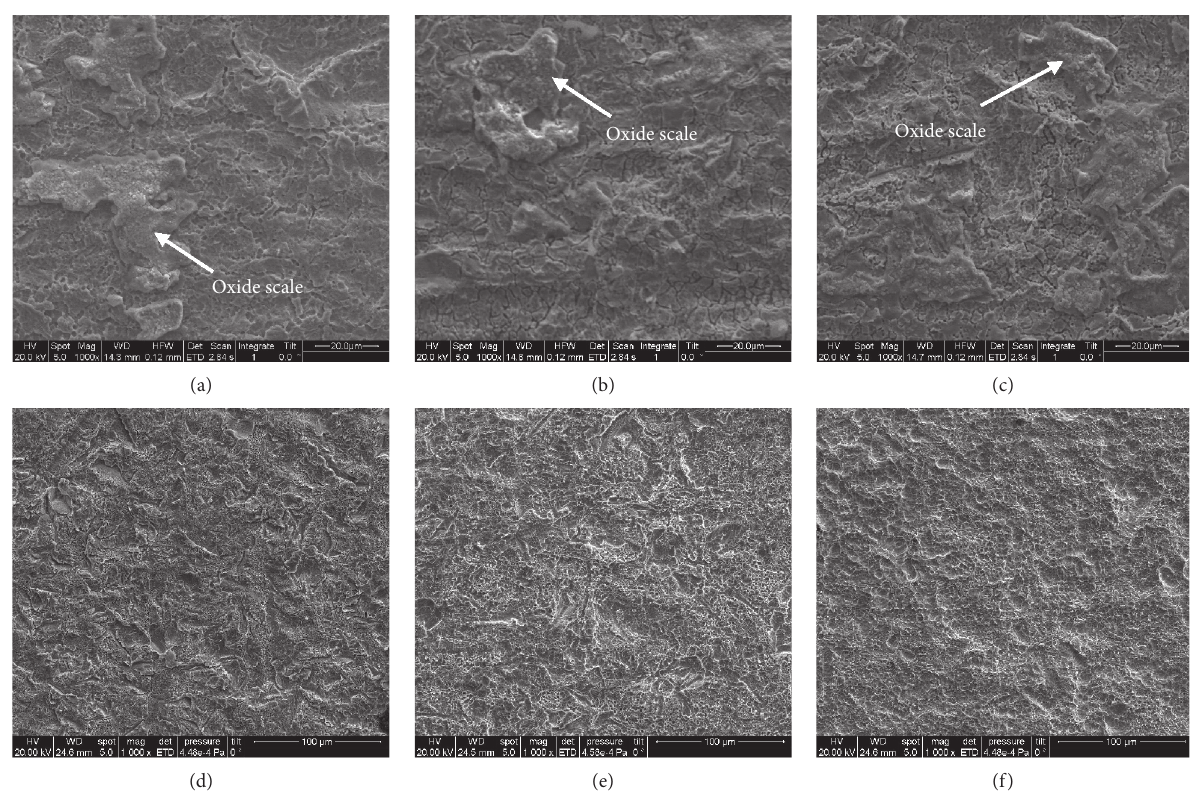
° C with current density 2 SO 4 solutions at 75